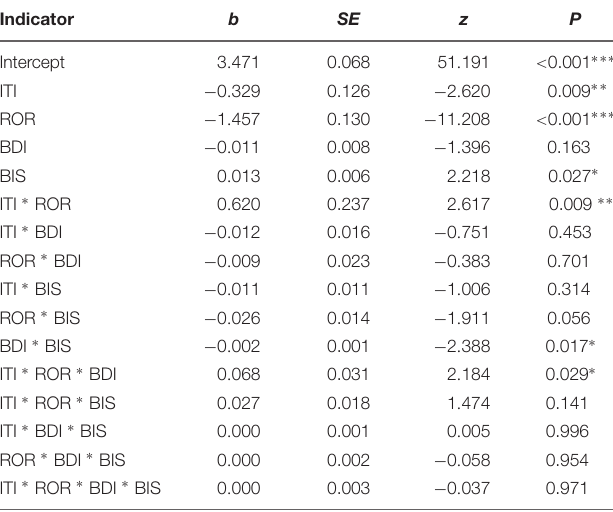
TABLE 3 | Full poisson regression model of extinction data with robust standard